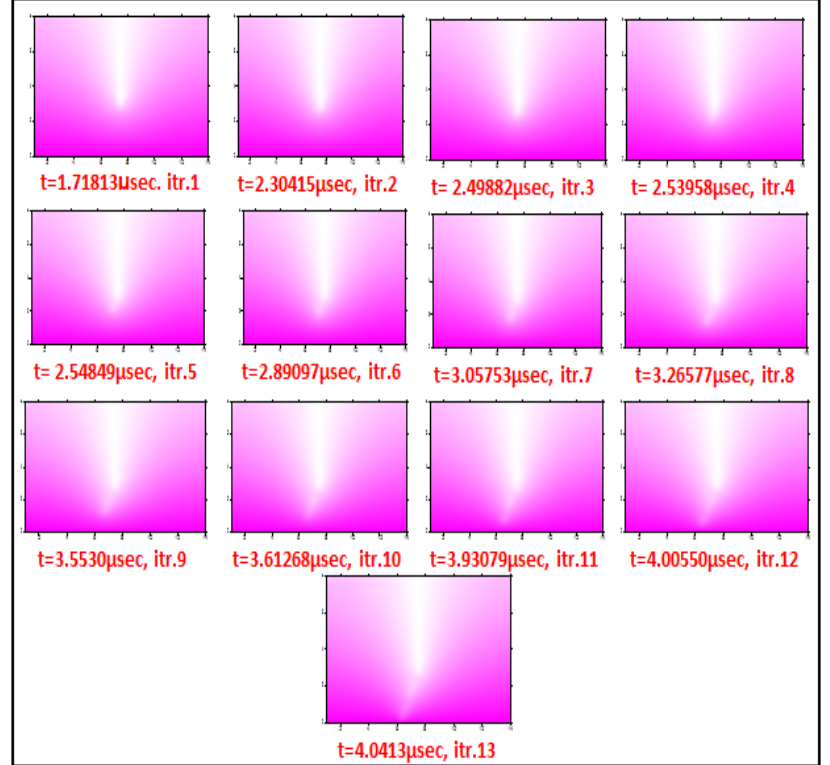
Fig. 4: The voltage distribution with the time within pin - plane configuration applied voltage of V = 13 kV.